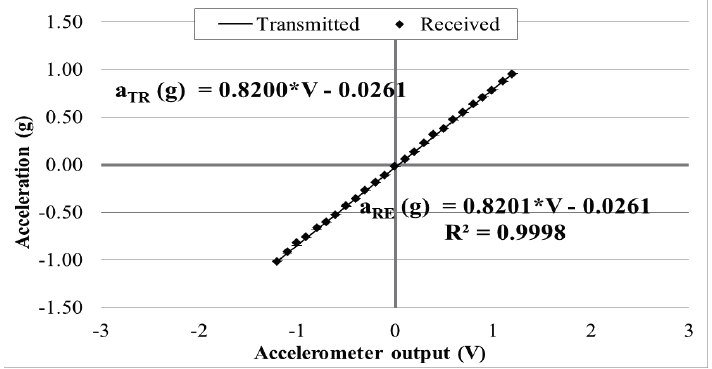
Figure 8. Calibration chart when receiver is 5 m away from transmitter.